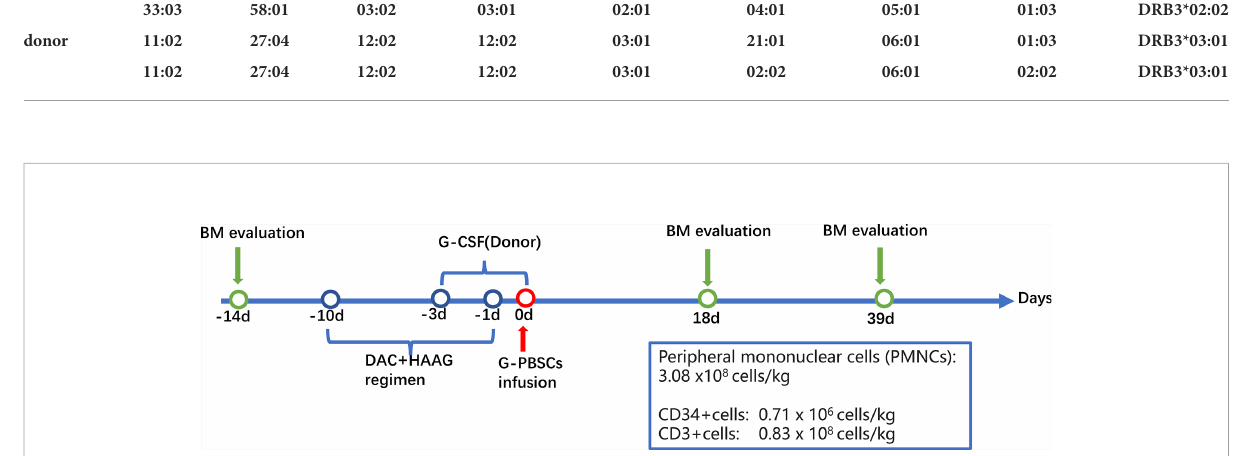
FIGURE 2 Flowchart of the micro-transplantation protocol. BM, bone marrow; DAC, decitabine; G-CSF, granulocyte colony-stimulating factor; HAAG, homoharringtonine (HHT), cytarabine (Ara-C), aclarubicin (Acla), and G-CSF; MST,